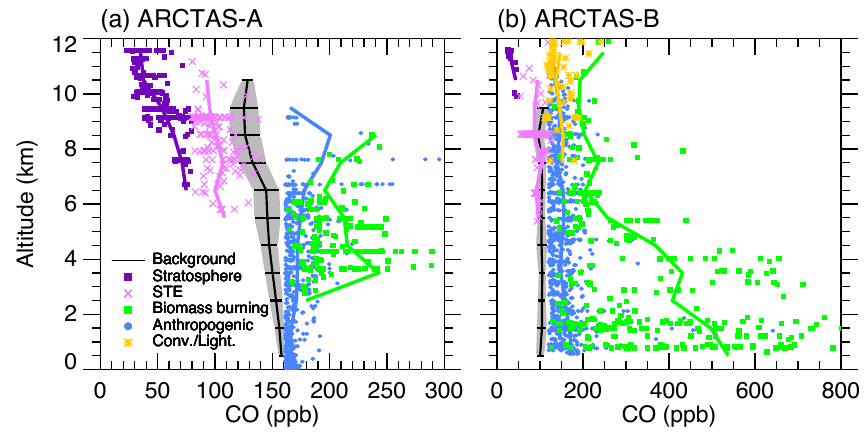
Fig. 3. Vertical profiles of CO during ARCTAS-A and ARCTAS-B. Black lines show the mean background CO at 1-km altitude bins, with gray shading indicating one standard deviation. We use colored symbols to show the individual air masses: stratosphere (purple), stratosphere-troposphere mixed (lilac), anthropogenic pollution (blue), biomass burning (green), and convection/lightning (yellow). The solid color lines indicate the vertical mean profiles of individual air